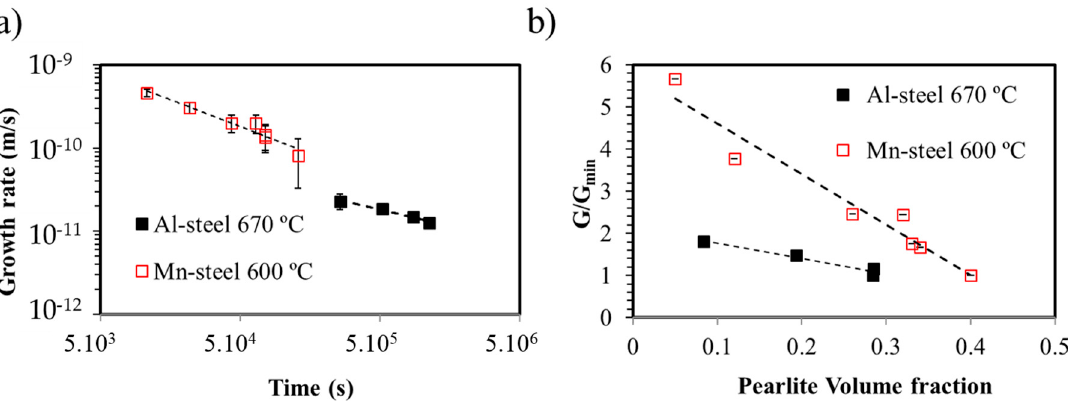
Figure 4. ( a ) Evolution of the growth rate of pearlite with time decomposition at 670 °C for the Fe–C– Mn–Al system and at 600 °C for the Fe–C–Mn system; ( b ) growth rate vs. pearlite volume fraction for the Mn- and Al-steel.